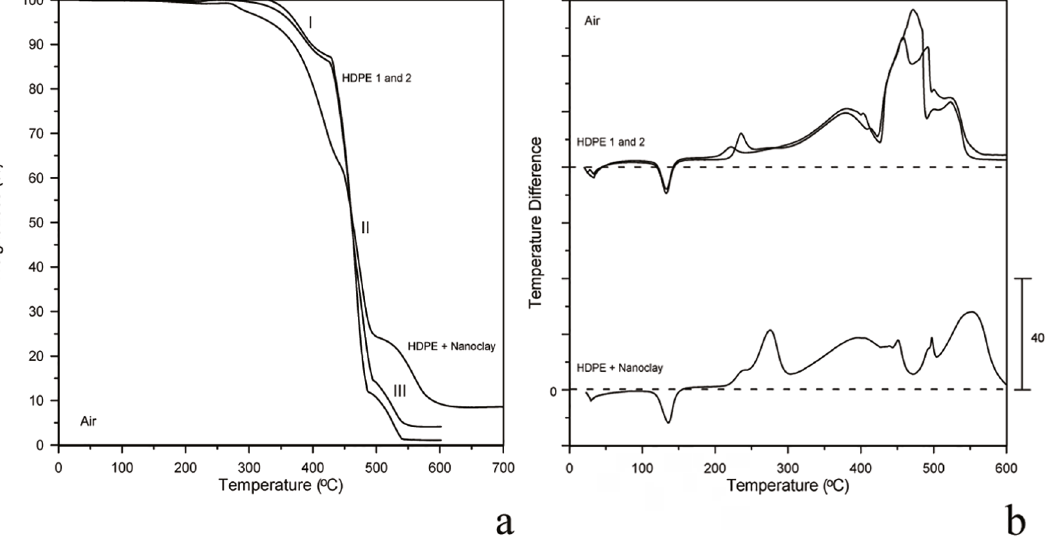
Figure 7. Thermal degradation in an oxidant atmosphere of the polyethylene (HDPE) and the composite polyethylene and nanoclay (HDPE + Nanoclay): a) Thermo gravimetric analysis, b) Differential thermal analysis. the medium and large molecular weight polymers shift and The second, third and fourth events (at about 400, 470 and 500 o C) corresponds to the thermal oxidation of polymers of reduce indicating that a high temperature is now necessary for medium and large molecular weight and the combustion of the oxidation of the polymers. This improvement in the thermal the heavy compounds (char). Quite distinct behavior for the stability of the polymeric matrix can be explained by the fact that the nanoclay can reduce the diffusion of oxygen and the nanocomposites can be seen, especially for temperatures above 450 o C. The peaks related to the thermal oxidation of volatile degradation products acting as a mass transport